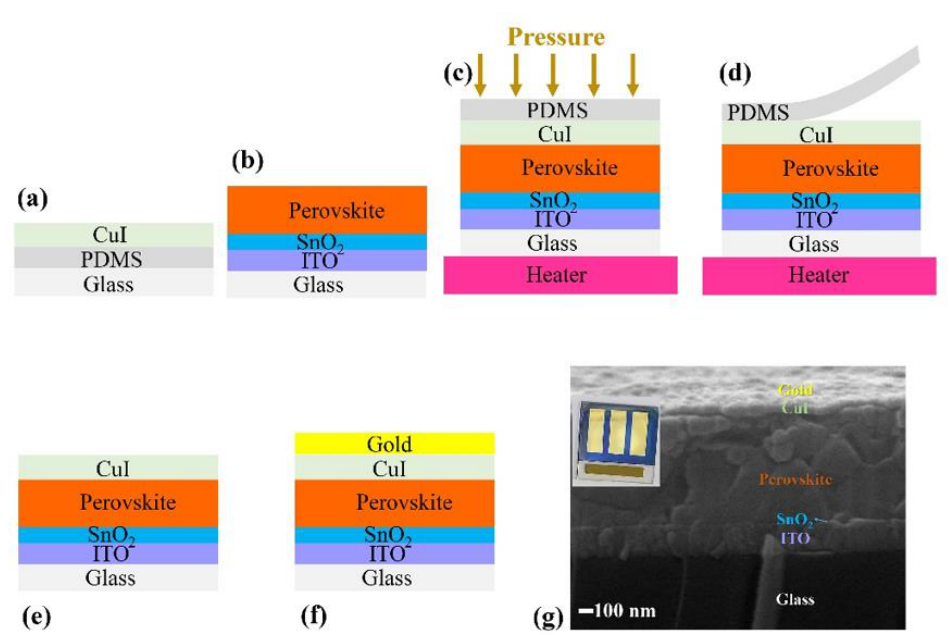
Figure 3. Schematic of device fabrication with transfer-printing of CuI. ( a ) Glass/PDMS/CuI stamp, ( b ) glass/ITO/SnO 2 /perovskite film, ( c ) CuI stamp and perovskite during transfer-printing, ( d ) PDMS detachment after transfer-printing, ( e ) glass/ITO/SnO 2 /perovskite/(transfer-printed) CuI, ( f ) glass/ITO/SnO 2 /perovskite/CuI/gold. ( g ) Cross-sectional image of PSC (inset laboratory-fabricated device) with transfer-printed CuI HTL.